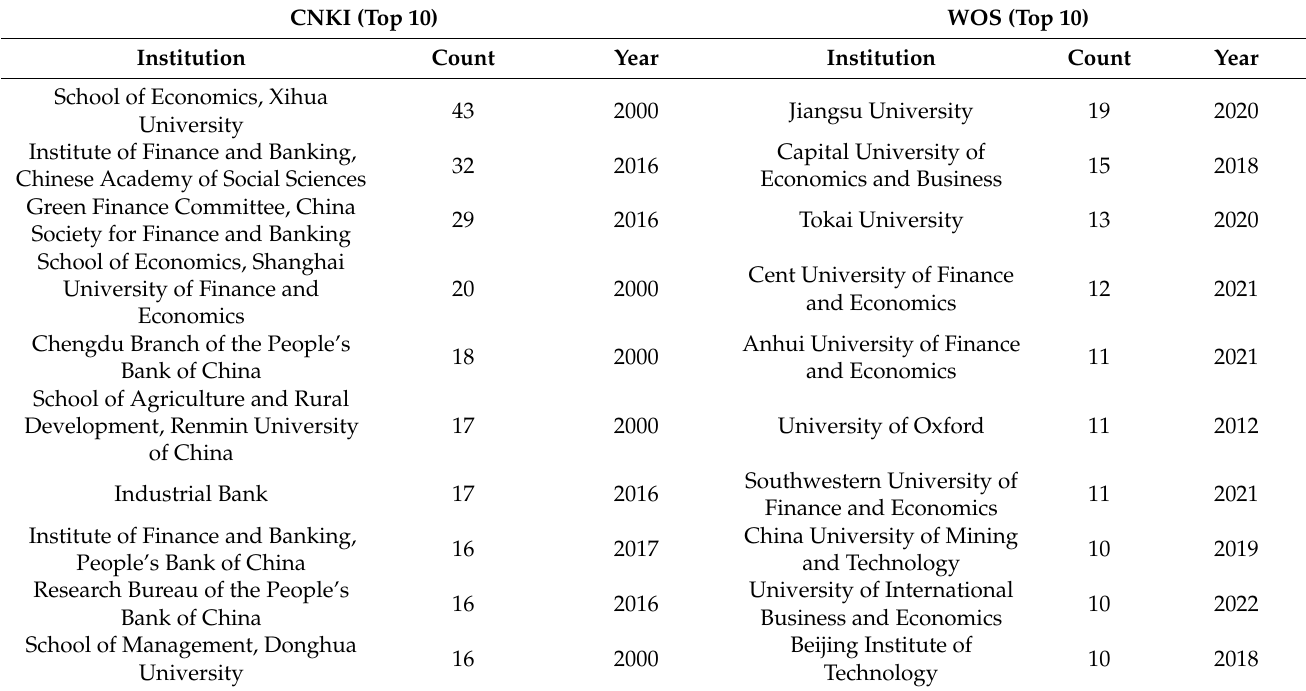
Figure 6. Network of the international institutions. Table 2. Comparison of the number of publications by research institutions (top 10).